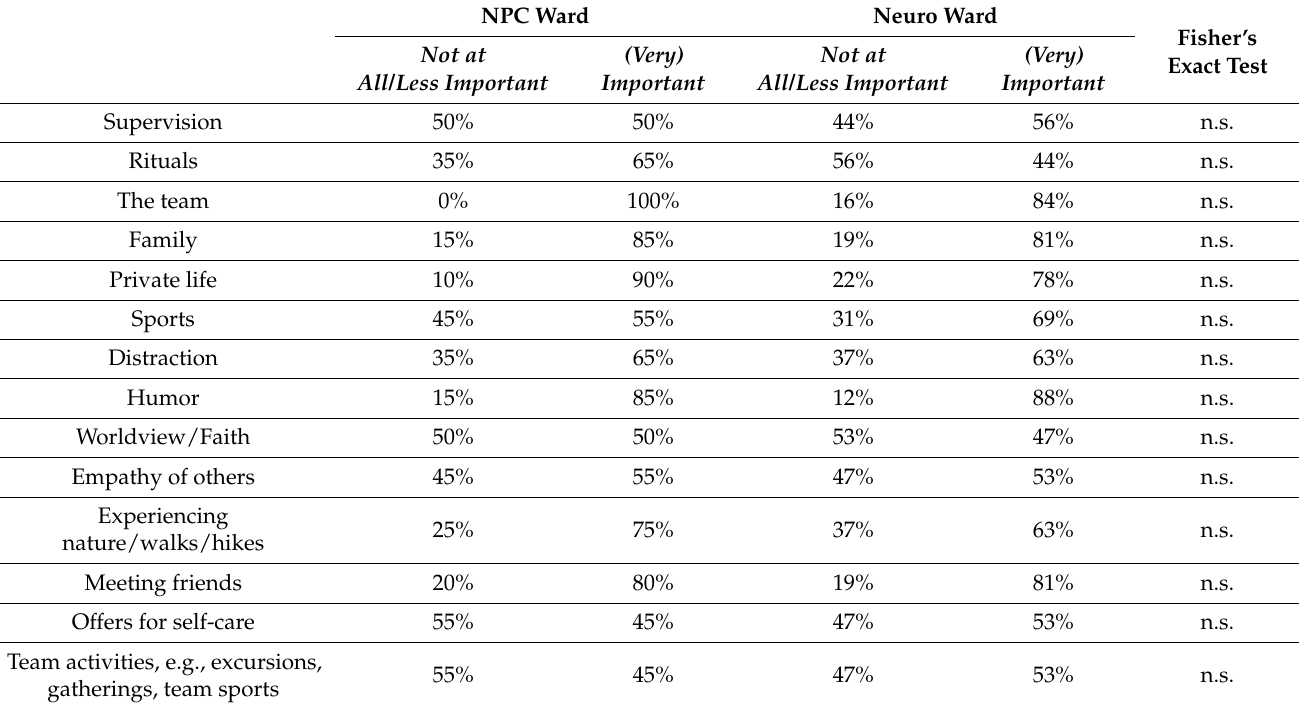
Table 3. Personal resources when dealing with death on the NPC ward and the neuro ward in relative numbers. The importance of resources was dichotomized in “not at all/less important” and “(very) important.” No statistically significant differences ( p < 0.05) were found.